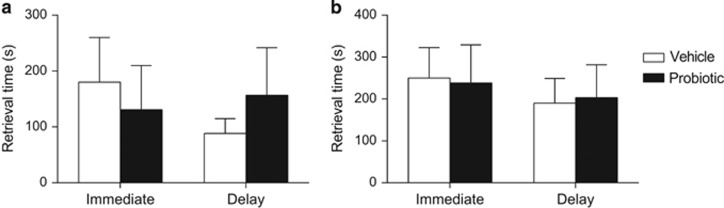
Mean (±s.e.m.) time for vehicle-treated (n=9) and probiotic-treated (n=7) maternally separated dams to retrieve the (a) first pup and (b) last pup to the nest. There were no significant effects of treatment on retrieval time, regardless of whether the test was conducted immediately after maternal separation, or at a delay (after a 3-h period of being united).